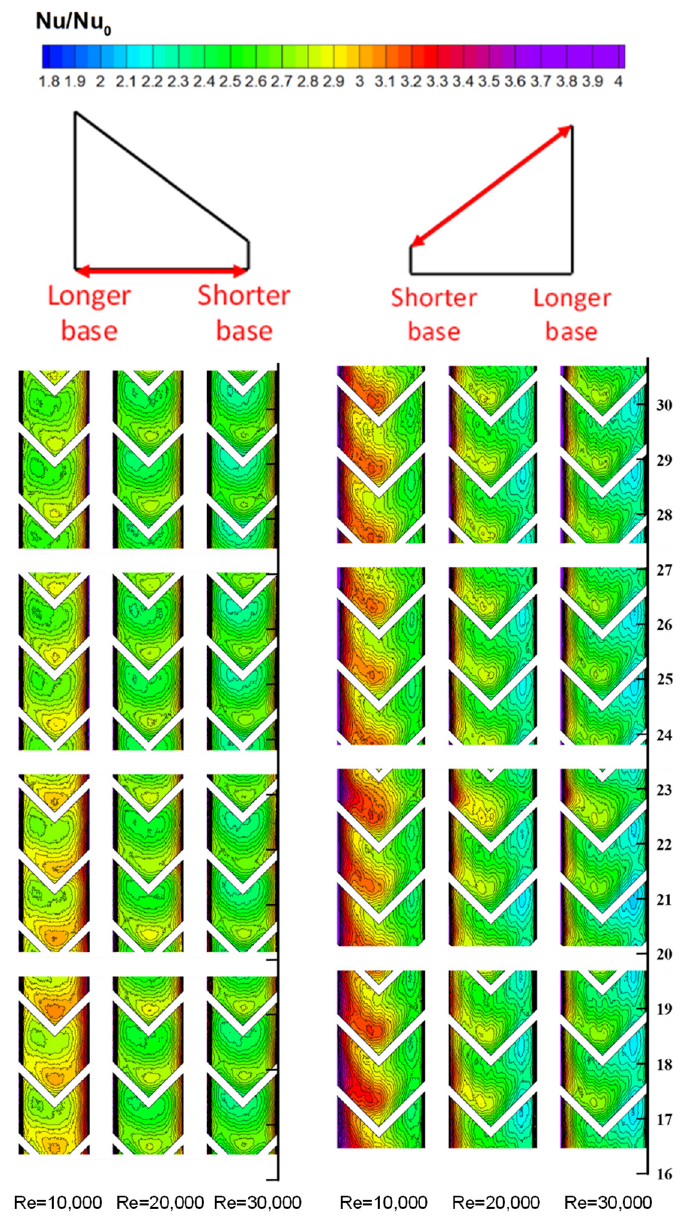
Figure 5. Nusselt number ratios for the V-shaped rib ( P/e = 10).